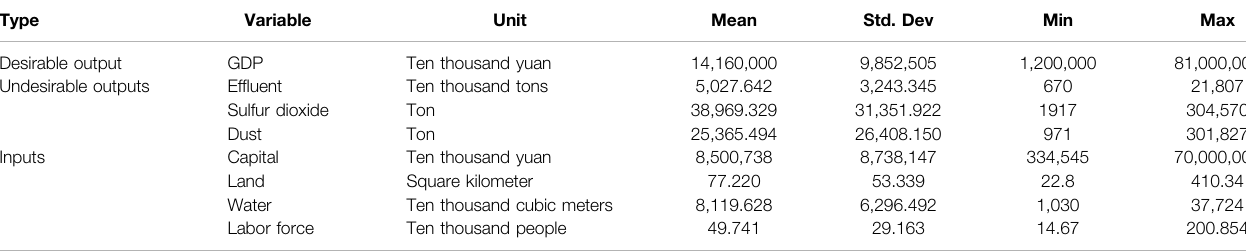
TABLE 2 | Statistical analysis of input-output variables.